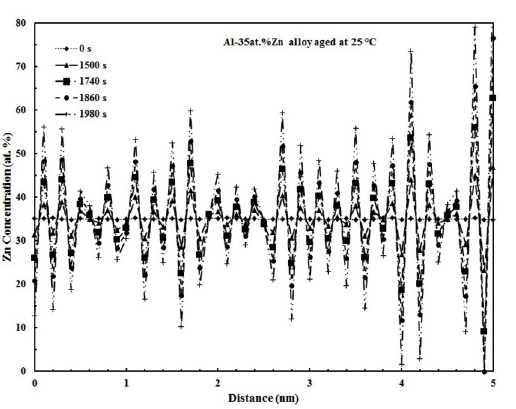
Figure 5. Zn concentration profiles of the Al-20at.%Zn alloy aged at 25 °C for different times. 25 °C for different times. The evolution of the modulation amplitude with aging time was higher in the Al-35at.%Zn alloy, Figure 3, than that in the Al-20at.%Zn alloy. This fact can be attributed to the higher driving force of the Al-35at.%Zn alloy which is located almost at the center of the miscibility gap in comparison with the latter alloy composition. This fact suggests a higher value of the amplification factor which time according to the Cahn-Hilliard spinodal